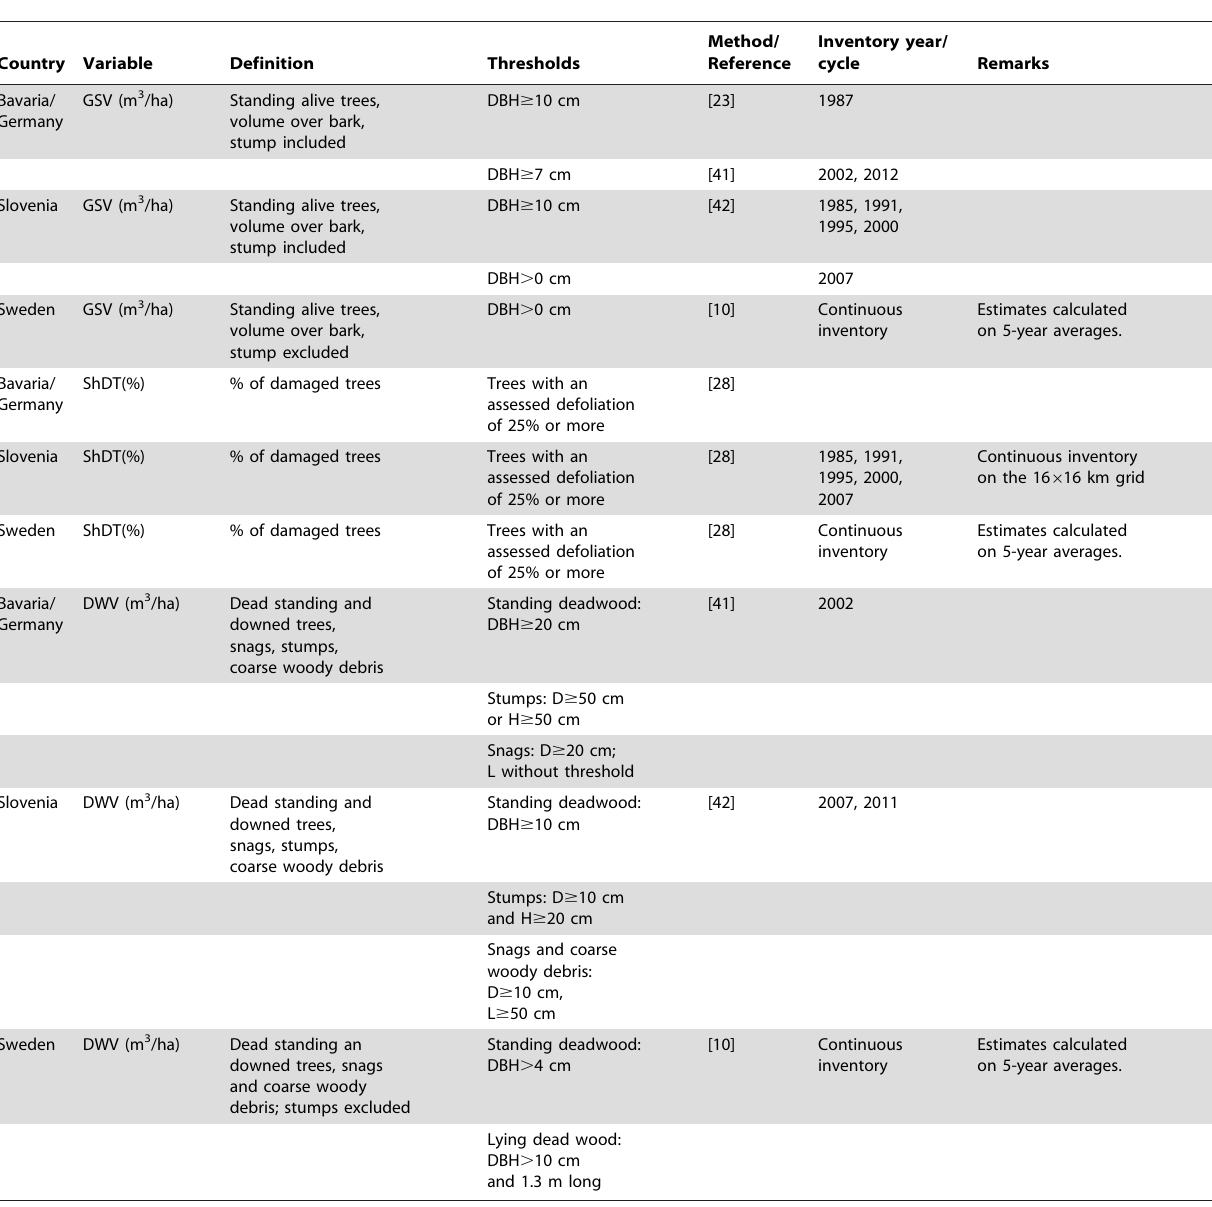
Table 1. Core variables and their definitions as used in the NFIs of Bavaria, Germany, Slovenia and